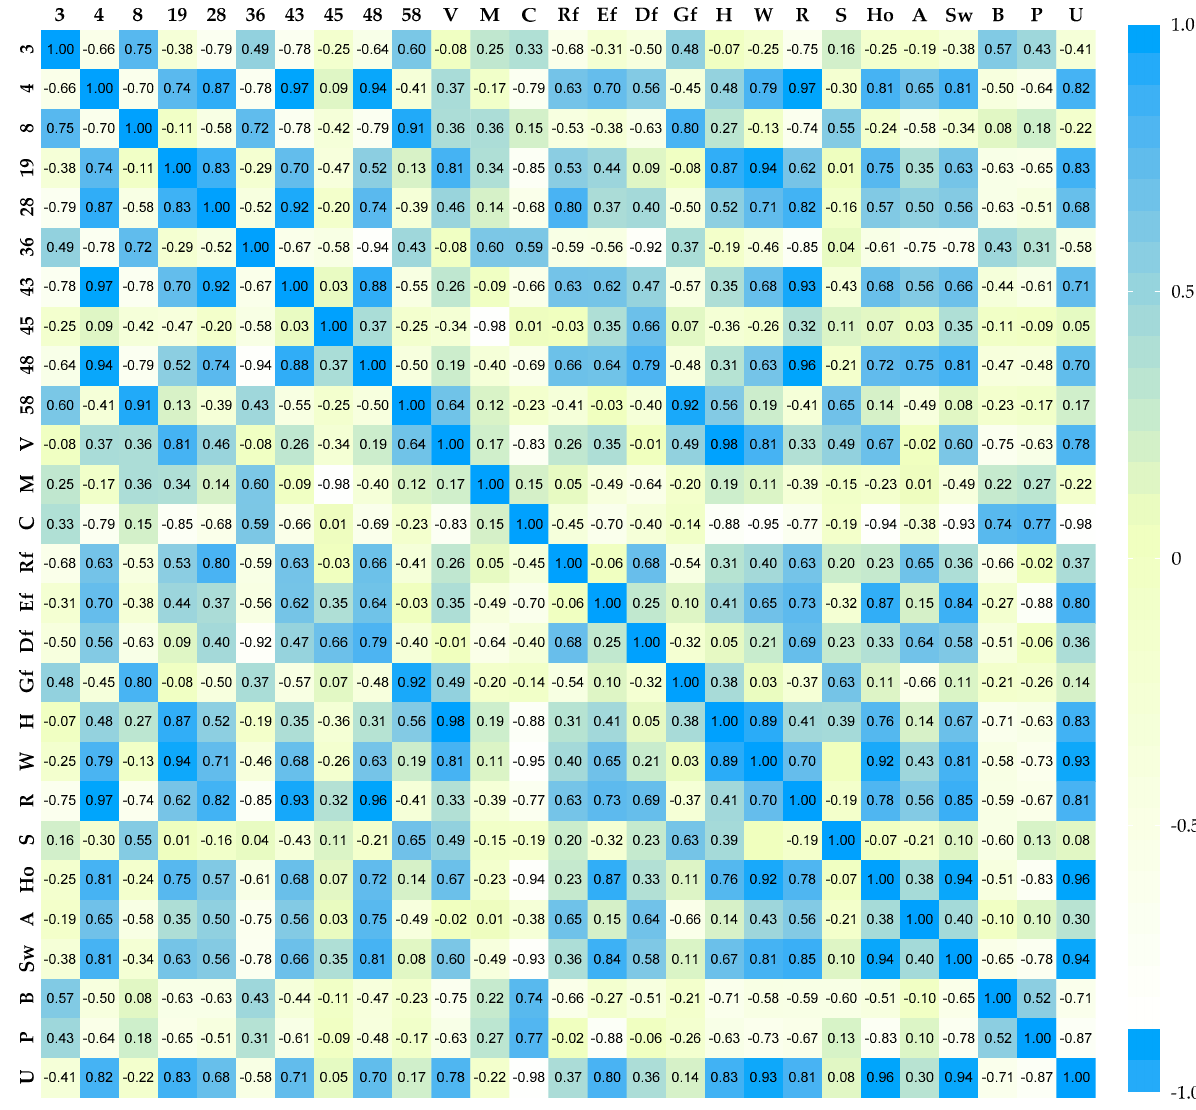
Figure 5. Pearson correlation on Feteasc ă regal ă samples. 3—3-methylpropan-1-ol; 4—3-methylbutyl acetate; 8—3-methylbutan-1-ol; 19—ethyl octanoate; 28—ethyl decanoate; 36—2-propanyl acetate; 43—hexanoic acid; 45—1-phenylethanol; 48—octanoic acid; 58—dimethyl